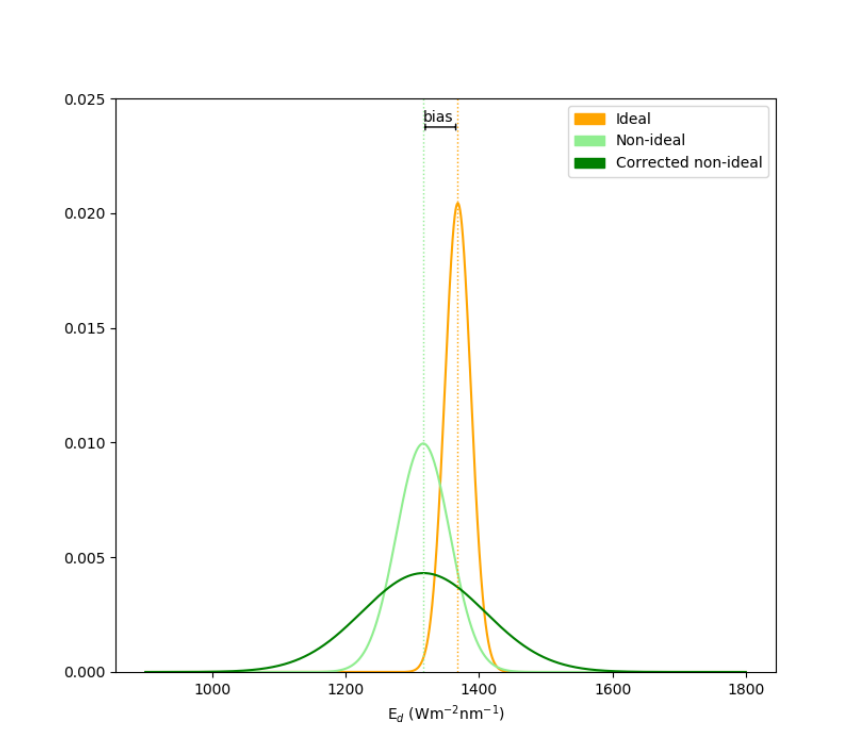
Figure 11. Representations of the histograms of E d for the ideal, non-ideal and corrected case showing the differences in the standard deviation. This is for cast 1 and the band with central wavelength of 778.8